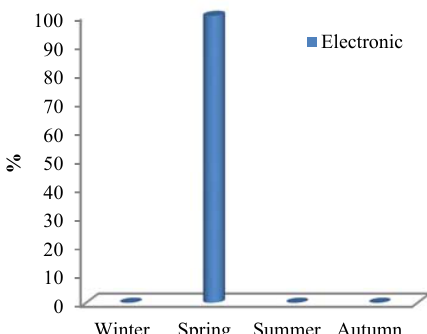
Fig. 6: According to season percentage of electronic wastes